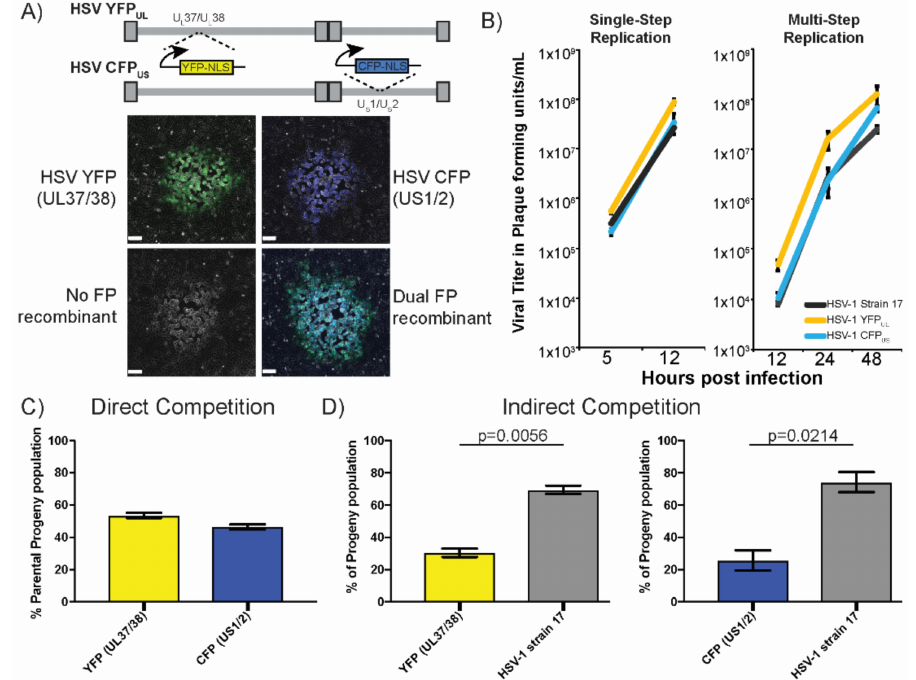
Figure 1. Characterization of the genetically tagged Herpes simplex virus (HSV) genomes. ( A ) Schematic representation of the fluorescent protein expression cassette location on the HSV-1 genome. Boxes represent large terminal and internal repeat sequences. Expression cassettes for yellow fluorescent protein (YFP)- and cyan fluorescent protein (CFP)-NLS proteins have been inserted in the UL36/37 and US1/2 loci, respectively. The genetic insertions result in different fluorescent expression phenotypes of the resulting viral plaques (images in panels below, scale bar = 100 µ m). Parental infections result in YFP and CFP positive plaques. Upon co-infection, the genomes can recombine, producing progeny containing both of the genetic cassettes. Those plaques will either express both of the fluorescent proteins (Dual FPs) or the lack fluorescent protein expression (No-FP); ( B ) single step replication plots of parent viral isolates; HSV YFP UL , HSV CFP US , and HSV-1 strain 17. The proportion of the viral progenies were plotted following the ( C ) direct competition assay between parent viruses and the ( D ) indirect competition assay against HSV-1 strain 17. The indicated FP expressing HSV virus or HSV-1 strain 17 were co-infected at an MOI of 10 for each virus. The total infected cells were harvested at 8 hpi. The harvested virus was plated at a limiting dilution on the cell monolayers and plaques and was scored based on the fluorescent protein expression. A statistical t -test comparison of the direct and indirect competition assays revealed significant differences between the wild-type and FP expressing